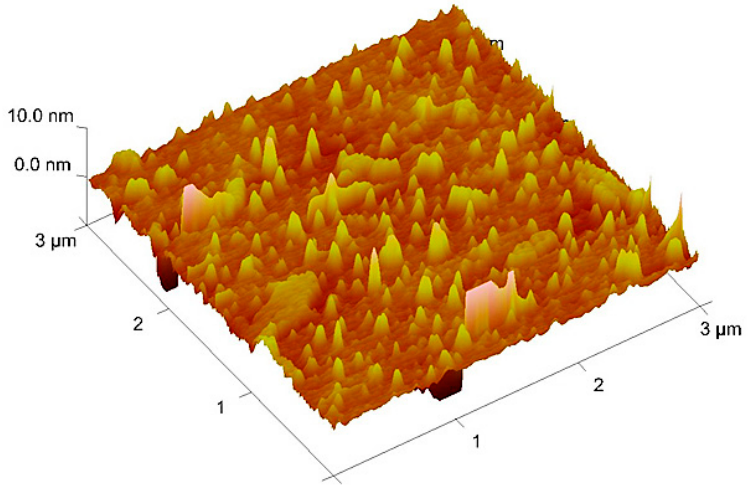
Figure 5. Atomic force microscopy (AFM) image of formaldehyde MIP nanoparticles.